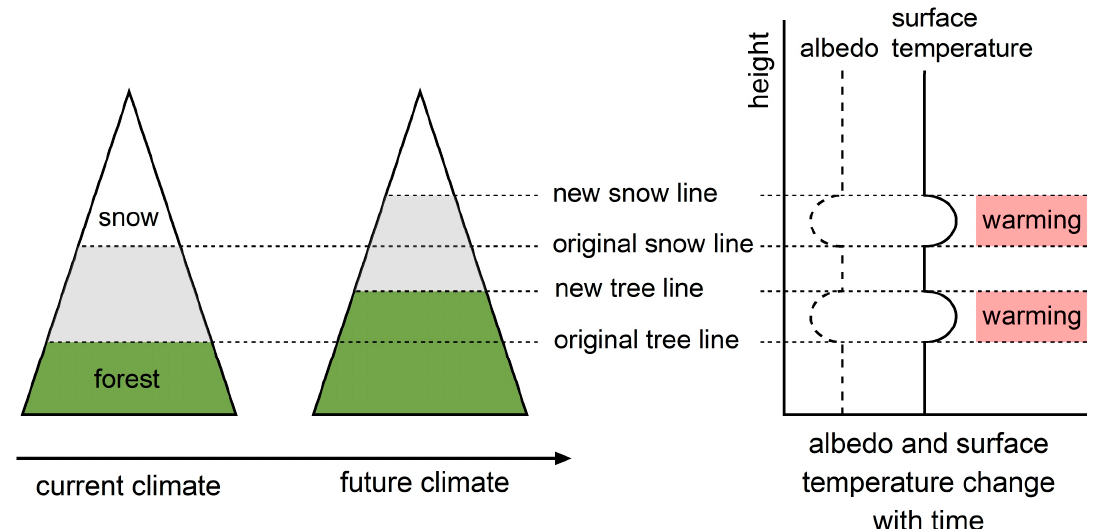
Figure 9. A positive albedo feedback mechanism to explain elevation dependent warming due to climate change. Climate change decreases albedo at altitudes with upslope propagating snow- and tree lines. A decrease in surface albedo changes the surface energy balance causing an increase in surface temperature (partially adapted from [26]).